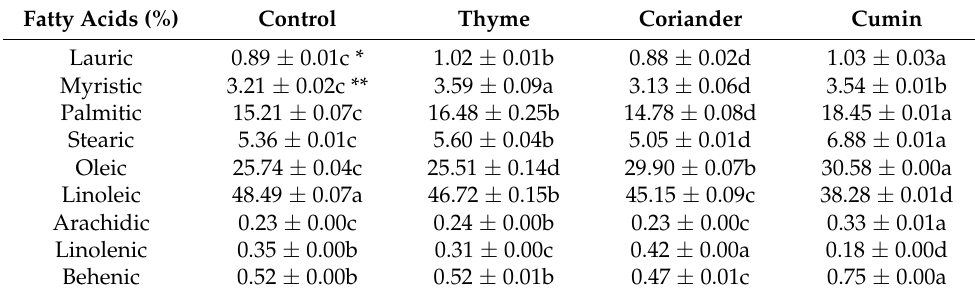
Table 3. Fatty acid composition of “Keşkek” oils.